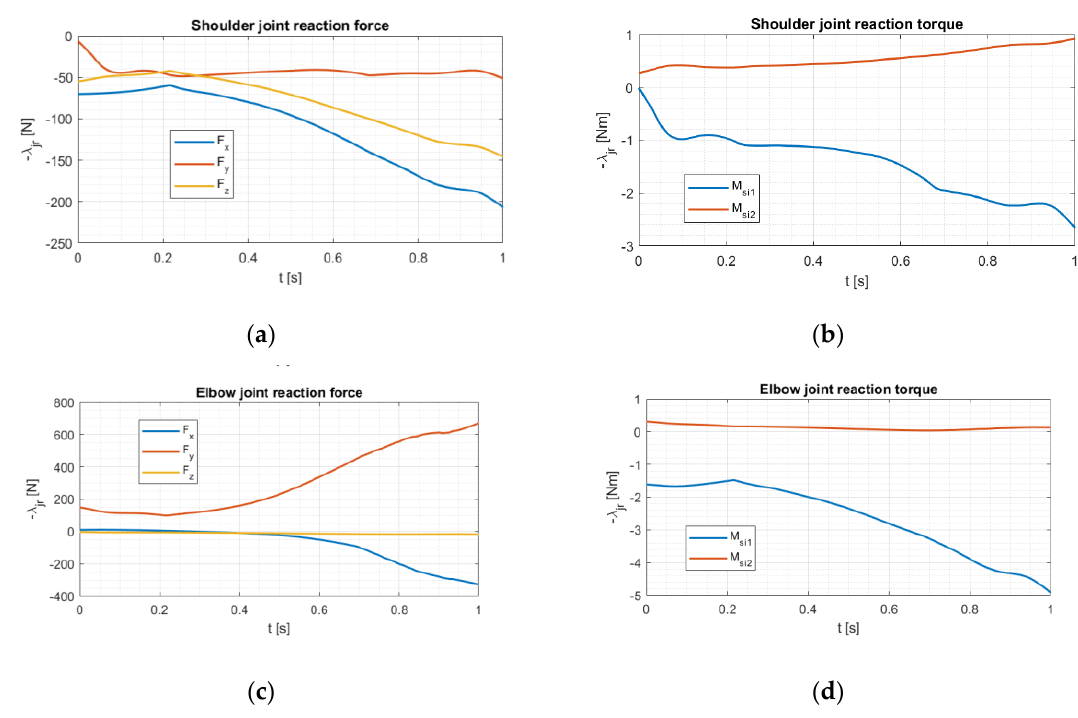
Figure 20. Upper limb joint reactions: ( a ) shoulder forces, and ( b ) torques, ( c ) elbow forces and ( d ) torques).